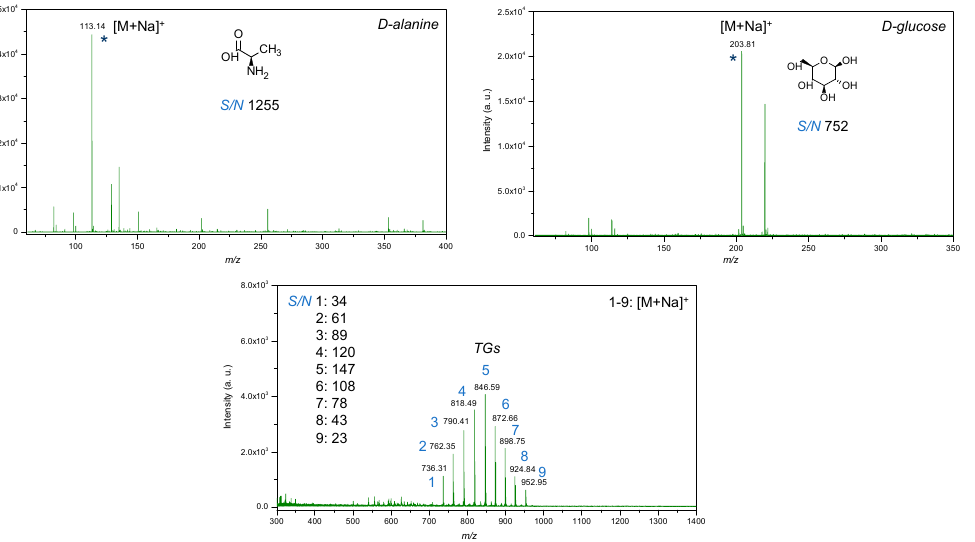
Figure 11. LDI-MS spectra of low molecular weight compounds (glucose, alanine, mixture of triacylglycerols) with utilization of IONPs as an inorganic matrix, where: 1—14:0-13:0-14:0 TG (25 μ g/mL); 2—14:0-15:1-14:0 TG (50 μ g/mL); 3—14:0-17:1-14:0 TG (75 μ g/mL); 4—16:0-15:1-16:0 TG